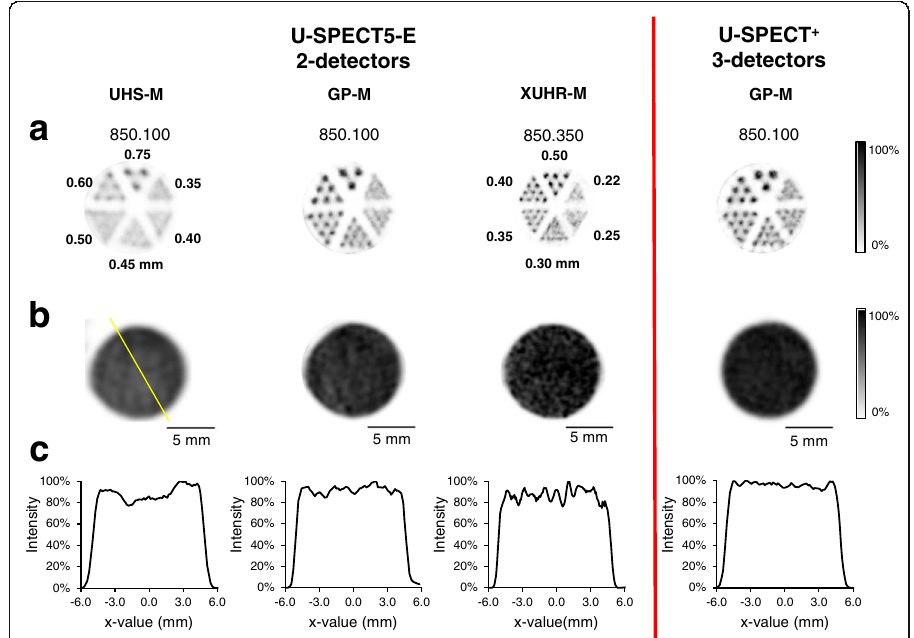
Fig. 3 SPECT images for assessment of spatial resolution with respective hot-rod phantoms ( a ) and uniformity with homogenously filled phantoms ( b ). c Shows corresponding line profiles illustrated as yellow line in ( b ). Contrasting juxtaposition of the three investigated collimators UHS-M, GP-M and XUHR-M. Right side shows data acquired with the 3DT-Scanner. Smallest discriminable rod size was 0.75 mm for the UHS-M, 0.50 mm for the GP-M (2DT-Scanner and 3DT-Scanner), 0.35 mm for the XUHR-M. Uniformity records 23.0% (UHS-M), 31.2% (GP-M), 16.3% (GP-M, 3DT-Scanner) and 41.3% (XUHR-M). Representative images were chosen with slice thickness of 0.2 mm for UHS-M and GP-M and 0.1 mm for XUHR-M, respectively, for optimal